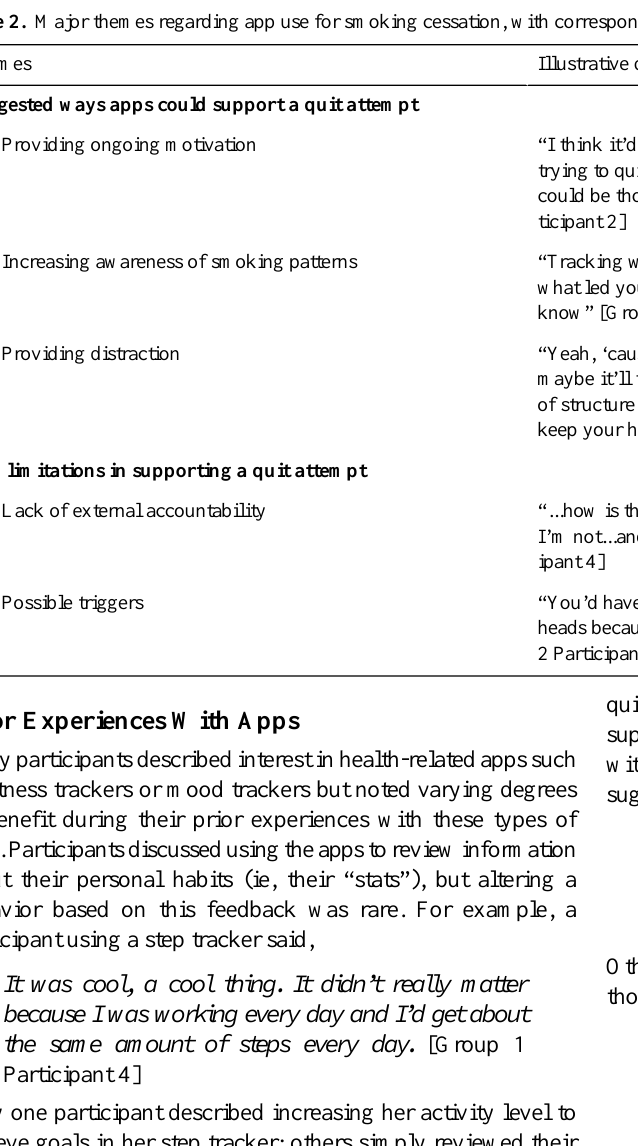
Table 2. Major themes regarding app use for smoking cessation, with corresponding illustrative quotations.